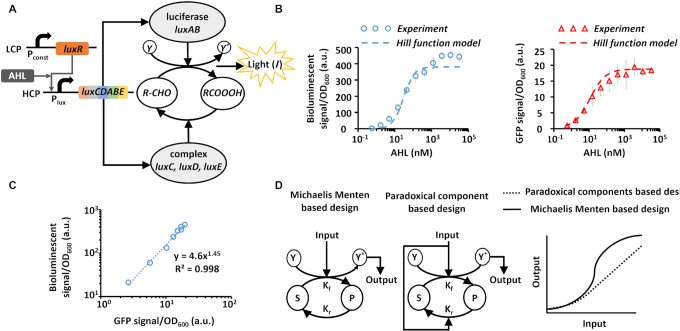
Studying the luxCDABE operon characteristics. (A) The luxCDABE operon is regulated by the Plux promoter located on a high-copy-number plasmid (HCP). LuxR is regulated by a constitutive promoter located on a low-copy-number plasmid (LCP) and is induced by acyl-homoserine-lactone (AHL). (B) Measured transfer function between AHL input concentration and either a green fluorescent protein (GFP, right) or bioluminescent (left) outputs. The dashed lines are fitted to Hill functions (for GFP according to \documentclass[12pt]{minimal}
\usepackage{amsmath}
\usepackage{wasysym}
\usepackage{amsfonts}
\usepackage{amssymb}
\usepackage{amsbsy}
\usepackage{upgreek}
\usepackage{mathrsfs}
\setlength{\oddsidemargin}{-69pt}
\begin{document}
}{}$\frac{{AHL}}{{AHL + 11}}$\end{document} and for bioluminescence according to \documentclass[12pt]{minimal}
\usepackage{amsmath}
\usepackage{wasysym}
\usepackage{amsfonts}
\usepackage{amssymb}
\usepackage{amsbsy}
\usepackage{upgreek}
\usepackage{mathrsfs}
\setlength{\oddsidemargin}{-69pt}
\begin{document}
}{}$\frac{{AH{L^{1.5}}}}{{AH{L^{1.5}} + 30}}$\end{document}). (C) The bioluminescent signal and the GFP signal comparison, relative to the same levels of AHL concentration. The GFP level regulated by Plux promoter are proportional to lux enzymes (D) Schematic model showing the linear behaviour of a system with paradoxical components compared to the non-linear behaviour of the Michaelis-Menten model. The average and errors (s.e.m.) shown in the figures are derived from three experiments.